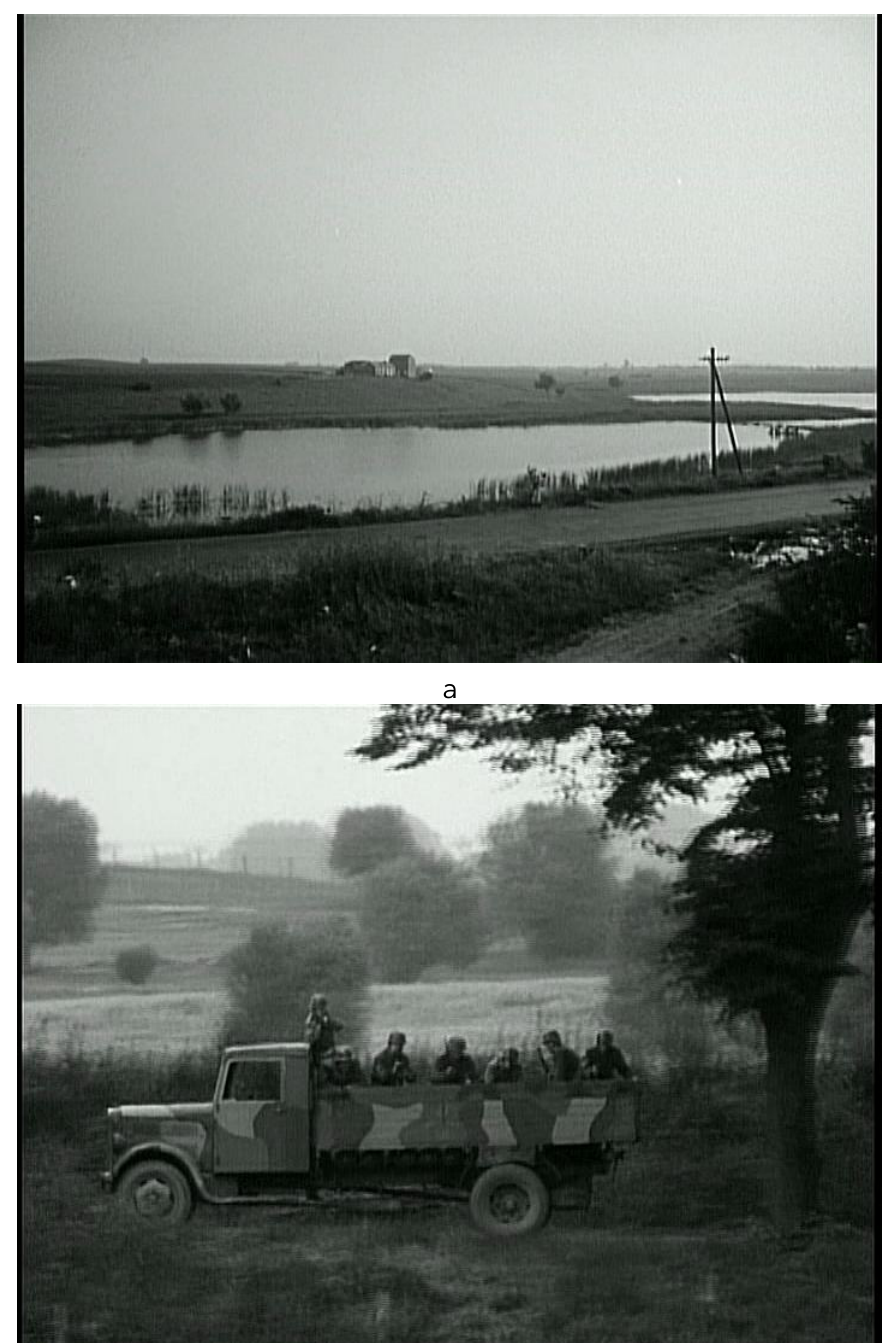
Figure 5. a. I was Nineteen , final scene: harmony of man and nature from the SS point of view. b. Gregor‘s point of view during the same scene shows the shooting SS-militants across the